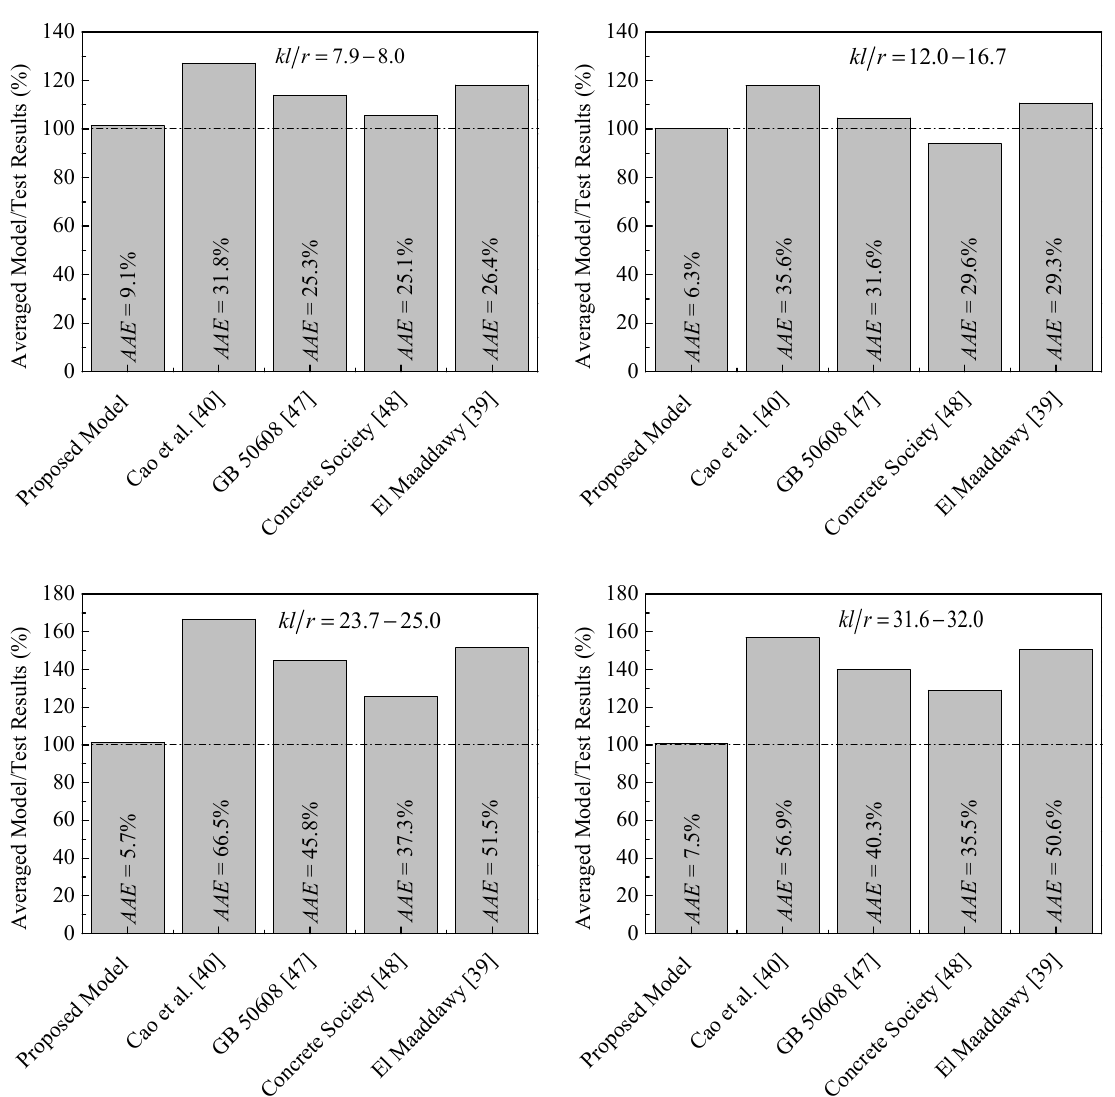
Figure 3. Comparison between proposed and existing peak strength models of FRP-confined concrete under eccentric loading.